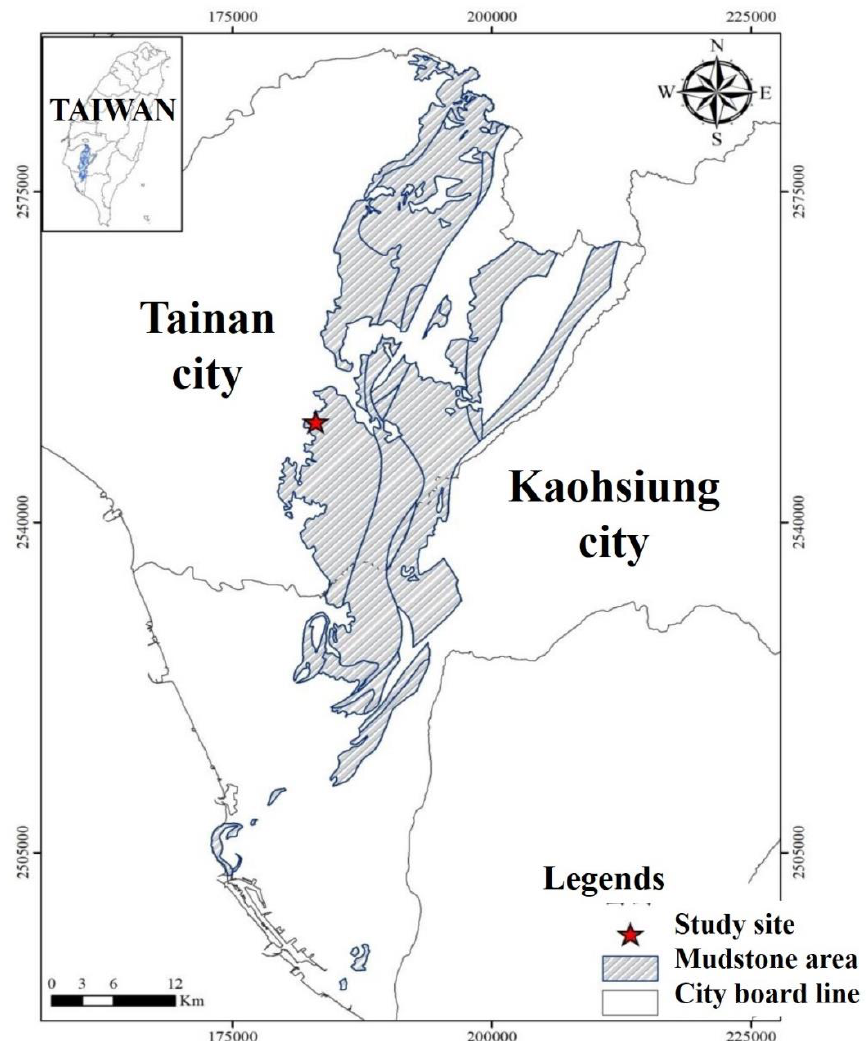
Figure 1. Location of the study site and distribution of mudstone in Southern Taiwan. Table 1. Basic properties of mudstone soils and biochars. Soil WB RHB Texture